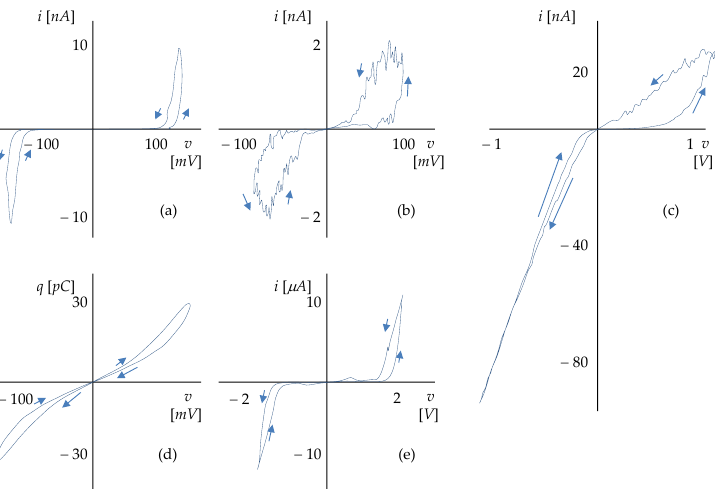
Figure 1. Different types of PHLs. ( a , b ) biomimetic memristors DPhPC and BTLE [13], ( c ) memristive UV sensor [11], ( d ) biomimetic membrane as a two-state memcapacitor [14], and ( e ) microtubular memristor [15].